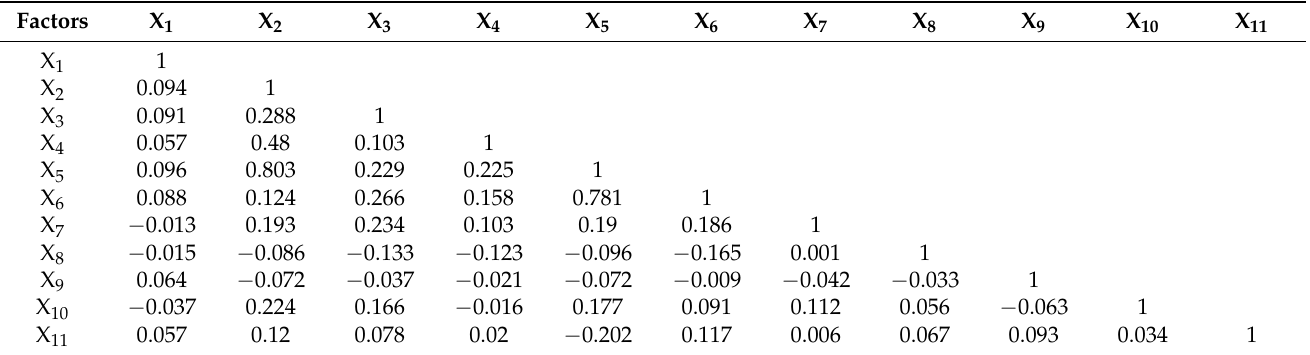
Table 1. Pearson correlation coefficient matrix for each evaluation